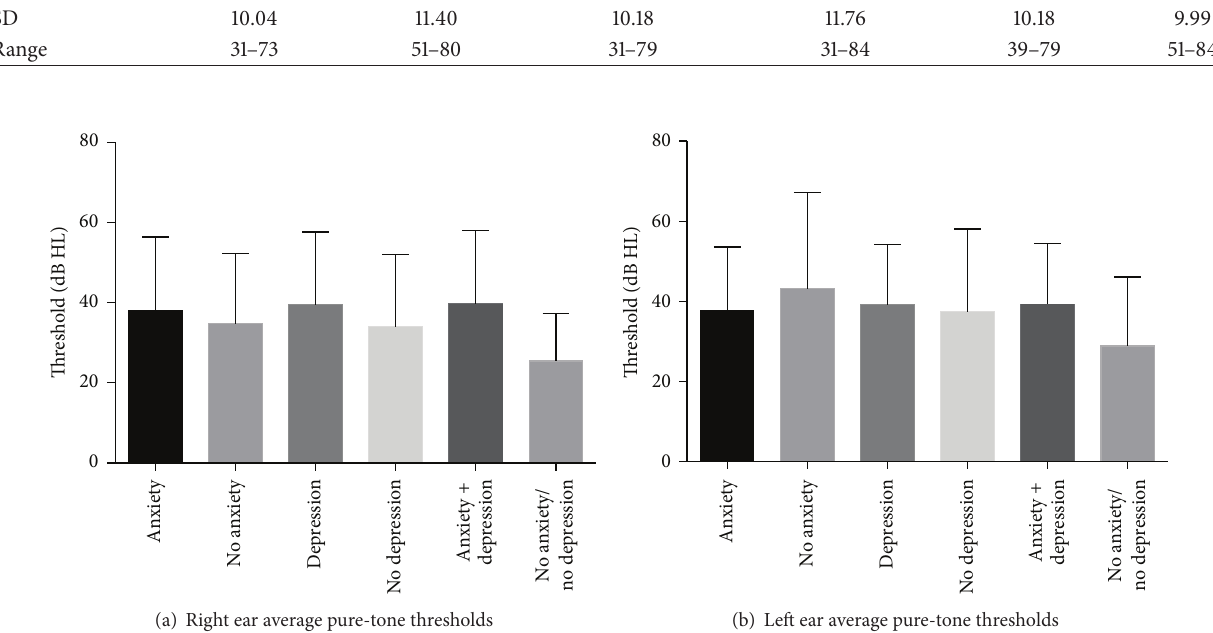
Figure 1: The pure-tone average (500, 1000, and 2000 Hz) of both ears among tinnitus patients with and without anxiety and depression.